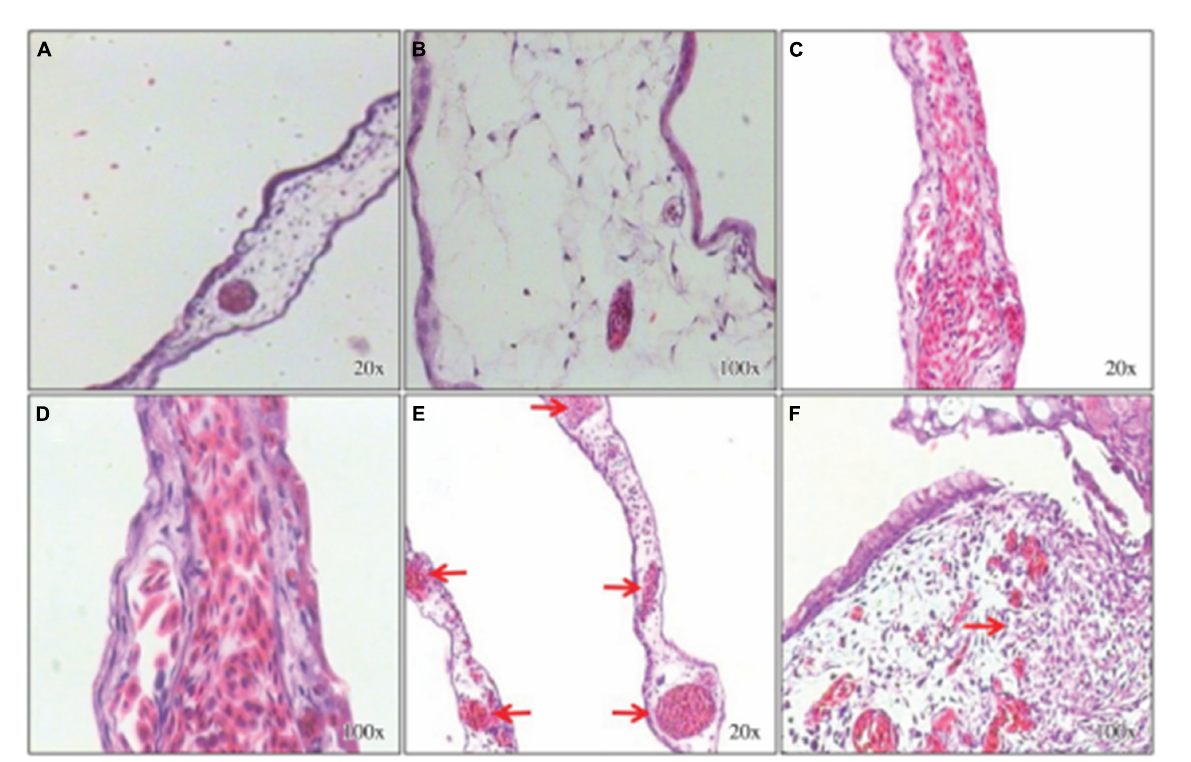
FIGURE18 Histological sections stained with hematoxylin-eosin. Chorioallantoic membranes (CAMs) treated with the inhibitor control (dexamethasone) show few connective tissue cells and few blood vessels (A,B) . The inducer control (Biocure Biomembrane of Hevea brasiliensis latex) treatment induced a large number of blood vessels and inflammatory foci (C,D) . Treatment with the test solution of Euphorbia tirucalli latex resulted in a large number of well-organized blood vessels and inflammatory foci (E,F) (Bessa et al.,